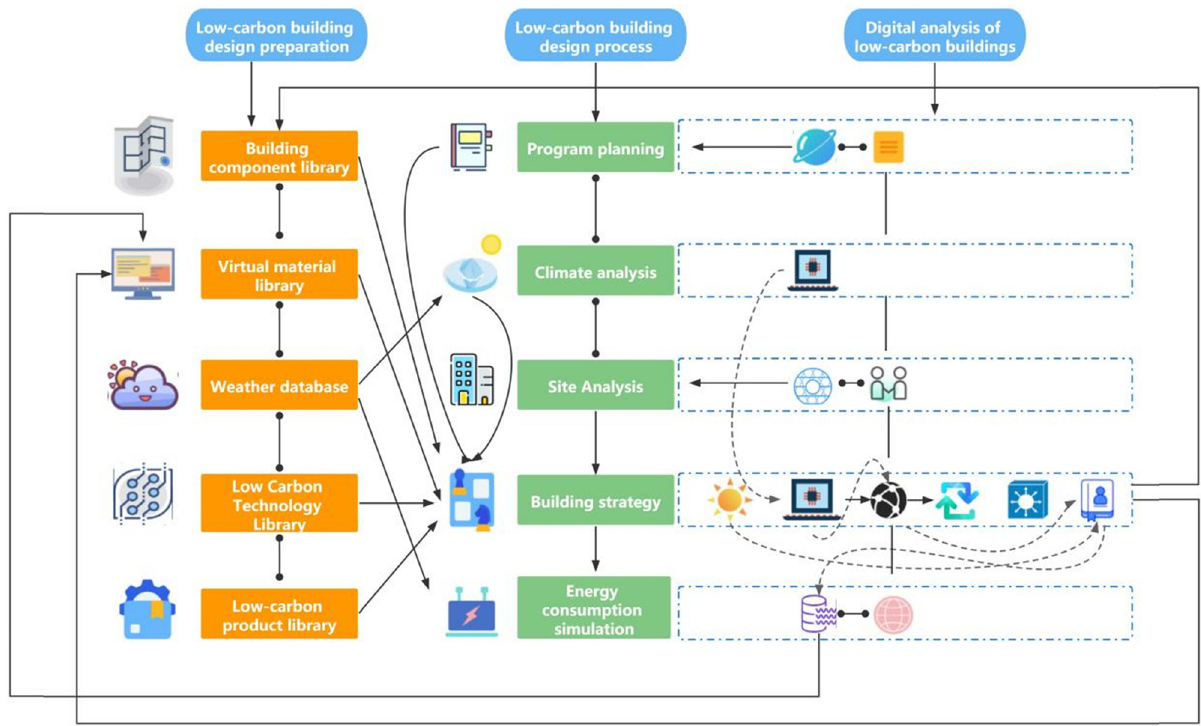
Figure 1: Application process of BIM technology in building energy - saving